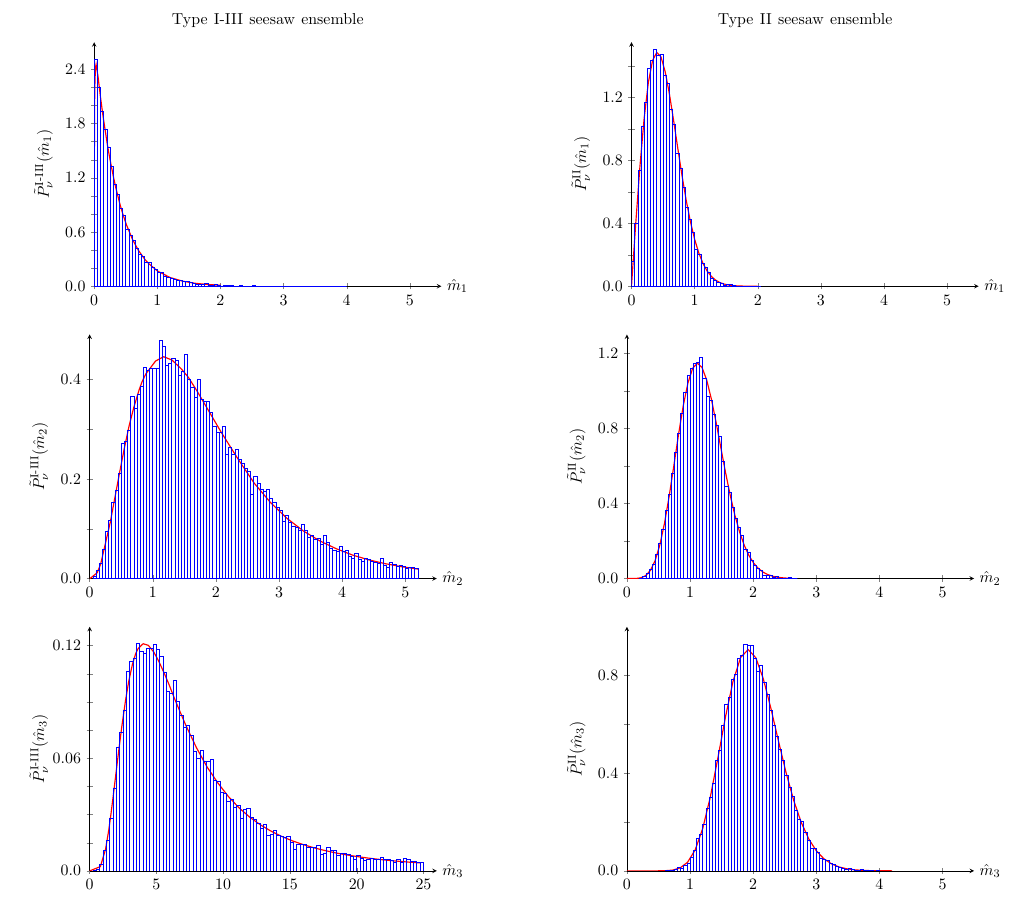
Figure 4 . Probability density functions for the singular values (masses) of the complex seesaw ensembles with N = 3. The red curve corresponds to the analytic result while the histogram corre- sponds to numerical results (with 2 : 5 10 4 dimensionless light neutrino mass matrices generated). (cid:2) The left and right columns show the pdfs for the smallest, median and largest singular values for the type I-III and the type II seesaw mechanisms respectively. The singular values are ordered such that 0 ^ m 1 ^ m 2 ^ m 3 and an extra factor of 3! is introduced to correct the singular value (cid:20) (cid:20) (cid:20)